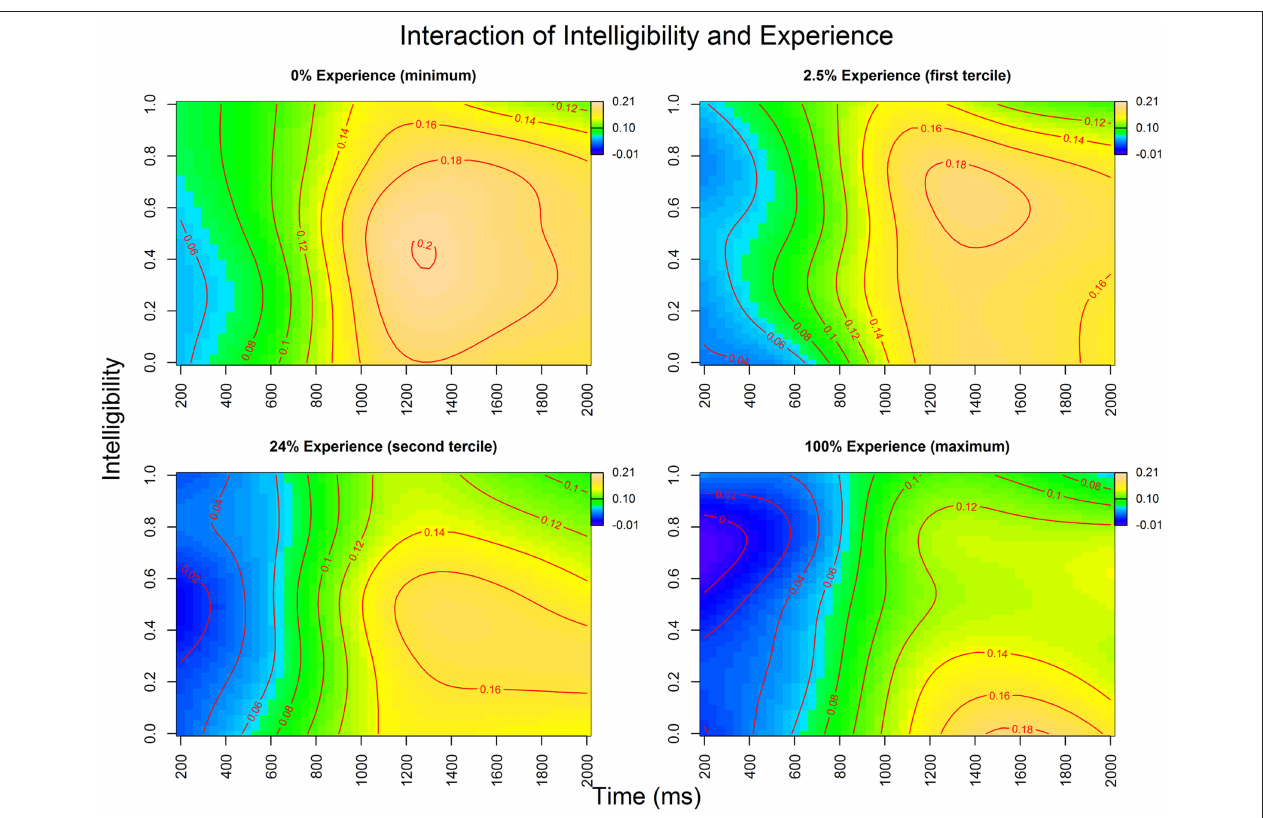
FIGURE 2 | Contour plots of the interaction between intelligibility and time at different values of experience. The plots presented represent experience at the minimum value, the first tercile, the second tercile, and the maximum value. Dark blue/purple indicate smaller dilation while yellow/white indicate larger dilation. The contour lines represent pupil dilation values predicted by the model.